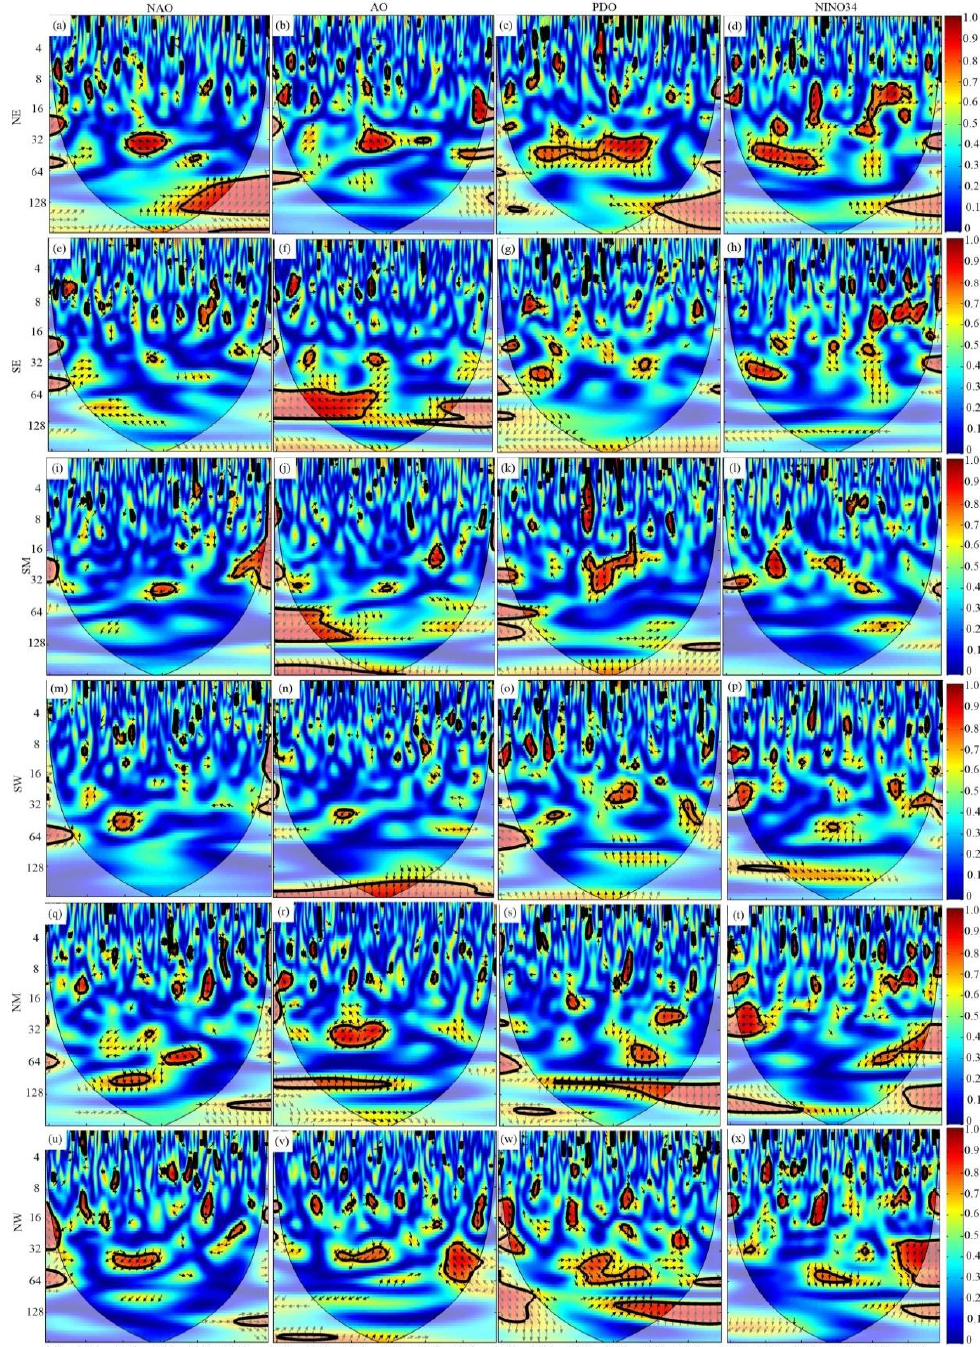
Figure 12. Wavelet coherence between the average scPDSI and four climate indices in the six sub-regions. Red denotes higher and blue denotes lower wavelet coherence values. The cone of influence is indicated by the light shade. The black contour is the local wavelet power relative to red noise with a 0.05 significance level threshold. The black arrows represent the phase condition.